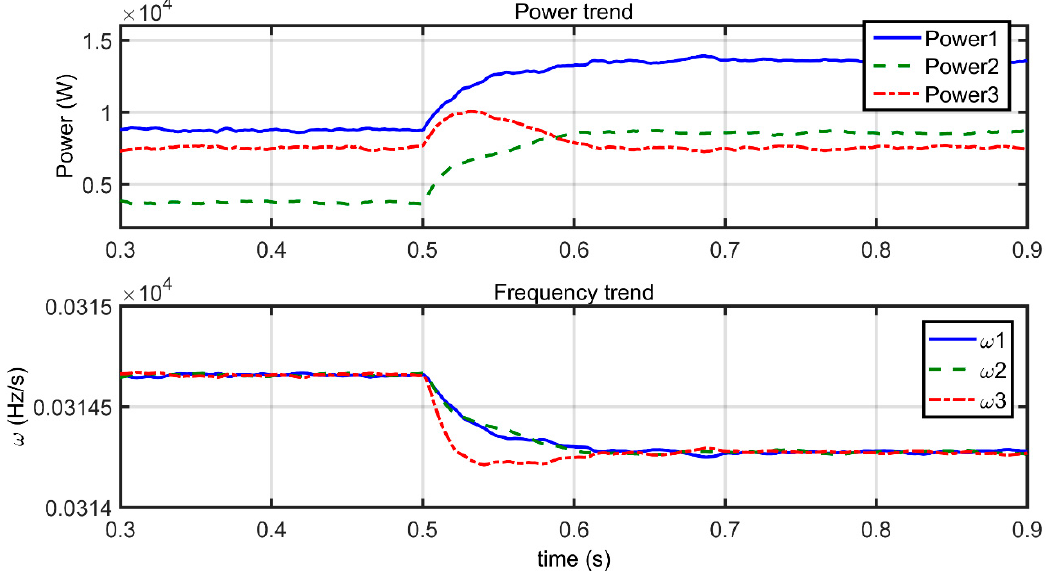
Figure 14. Power and Frequency Trend Case IV.